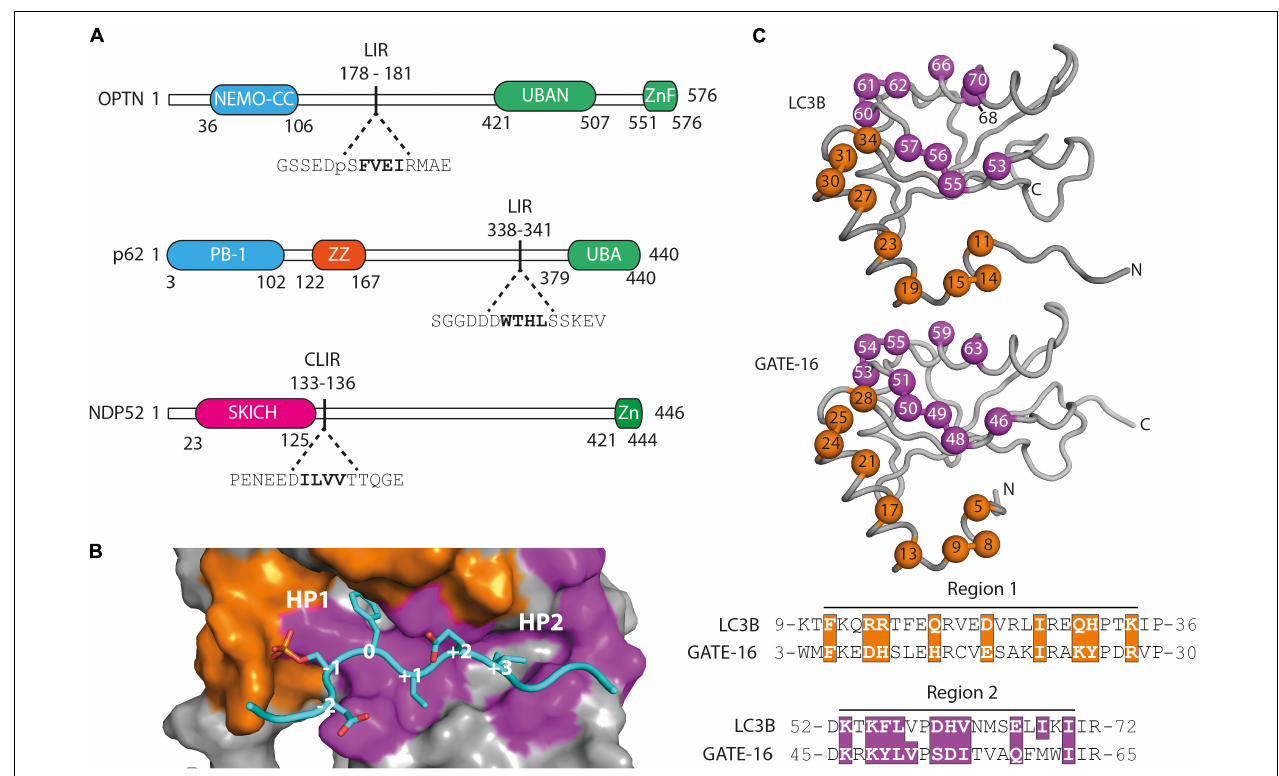
FIGURE 1 | Functional domains in the targeted autophagy receptors and library design. (A) OPTN, p62 and NDP52 are multifunctional proteins that contain domains mediating multimerization (blue) and cargo recognition (green). In p62, the ZZ domain (orange) binds arginylated (Nt-R) substrates (Zhang et al., 2018). The SKICH domain (magenta) of NDP52 has been shown to bind to intracellular membranes (Von Muhlinen et al., 2012). The four amino acid linear LC3 interaction region (LIR) is shown in bold in its broader amino acid context. (B) Surface representation of the LIR binding site of LC3B in complex with a pS177 OPTN peptide (cyan). Region 1 (orange) and region 2 (purple) are shown. Hydrophobic binding pocket 1 (HP1) coordinates position 0 (Trp, Phe or Tyr) residues and HP 2 coordinates position +3 residues (Leu, Val or Ile) in canonical LIR peptides. (C) LC3B (pdb: 3VTU) and GATE-16 (pdb: 1EO6) library design. Surface exposed residues (spheres) in region 1 (orange) and region 2 (purple) that mediate binding to LIR motifs have been randomized and are shown below in the context of their aligned primary amino acid sequence. Amino acid positions of the boundaries of regions 1 and 2 are